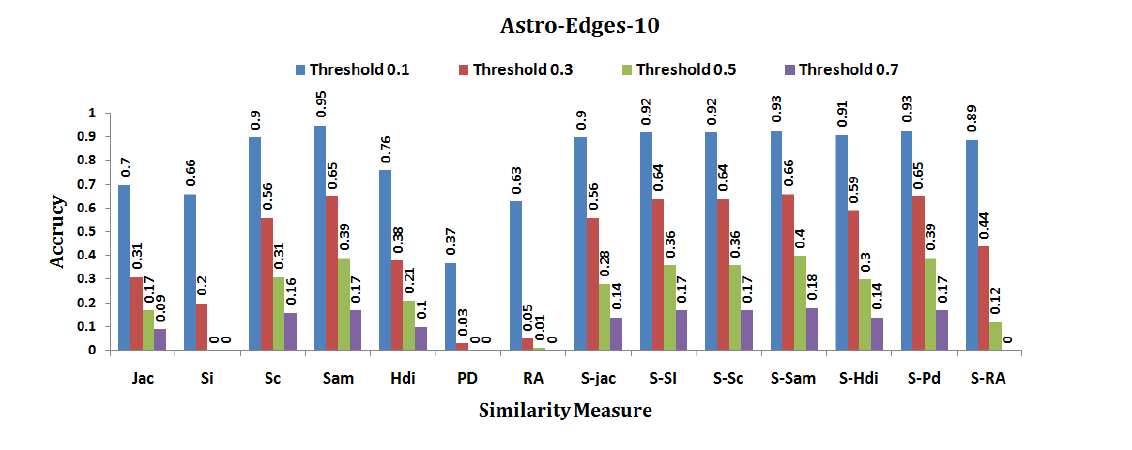
Figure 3. Prediction Results using Astro Dataset with 10% Edges